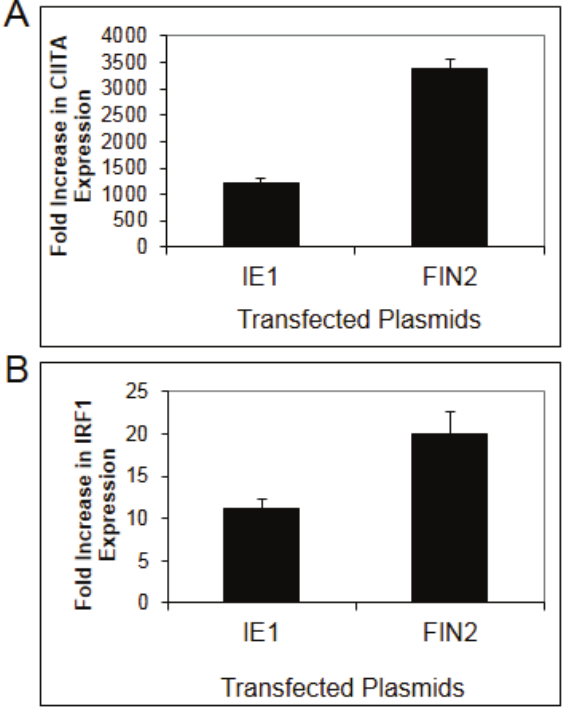
Figure 1. Diminished interferon-induced gene expression in human fibroblasts expressing IE1. MRC-5 fibroblasts were nucleofected with plasmid pIE622 harboring the UL123 gene specifying IE1, or the pFIN2 empty vector. At 24 hours post-nucleofection, the cells were exposed to 100 U/mL of IFN γ or were left untreated. At 6 hours after treatment, total RNA was isolated and subjected to Real Time RT-PCR analysis as described in Materials and Methods. The fold increase in CIITA ( A ) ( p value = 0.053) or IRF1 ( B ) ( p value 0.017) transcript levels in IFN treated cells relative to untreated cells was determined by the ΔΔ Ct method. Data shown are the average of three independent experiments.